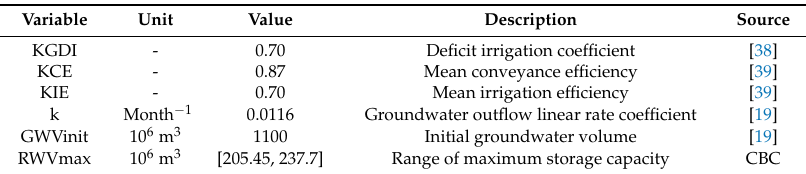
Table 2. Impact model